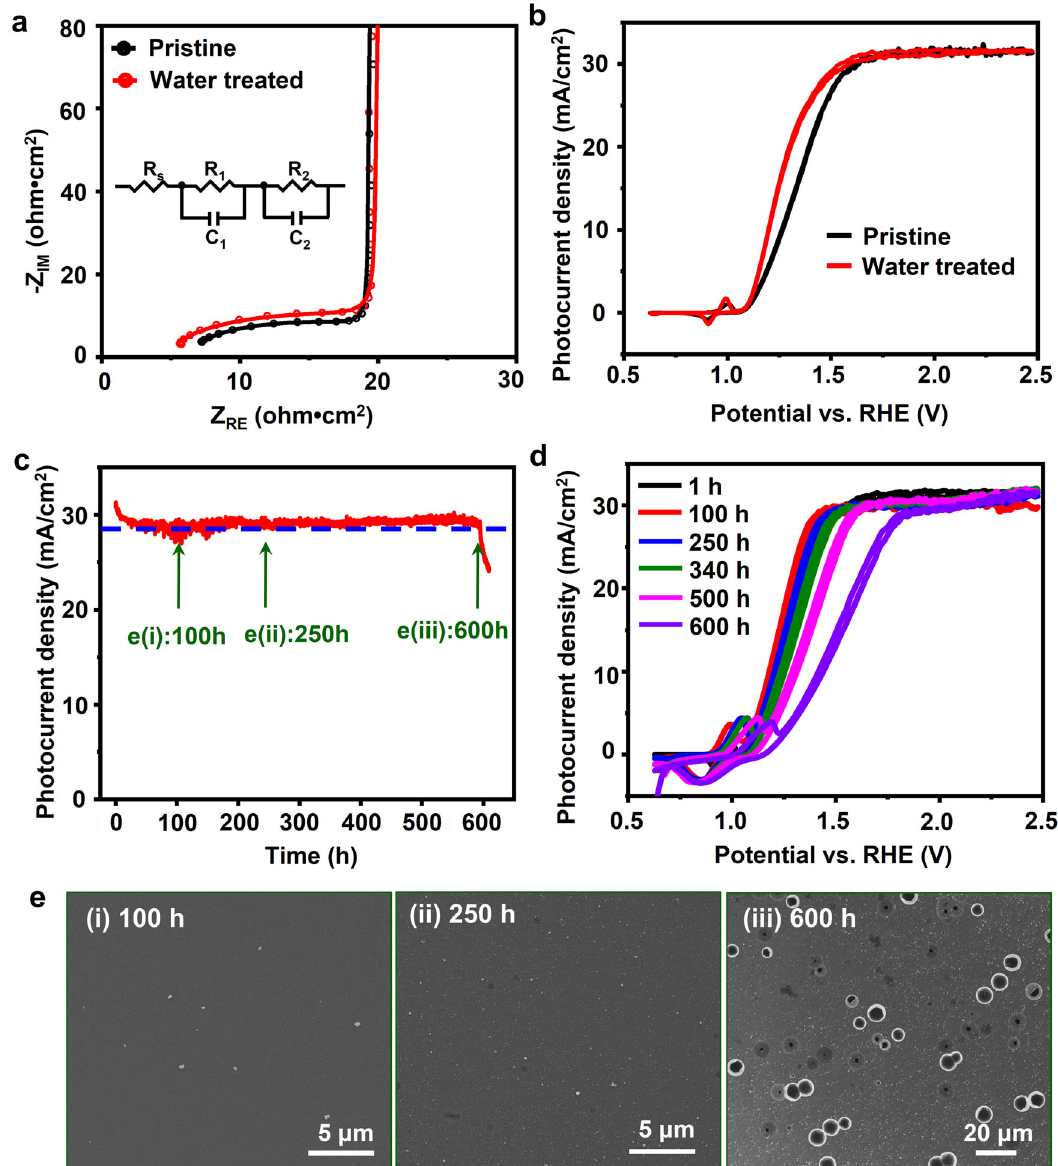
Fig. 5 | Lifetime evaluation of water-treated TiO 2 fi lm for Si photoanodes pro- 1sunilluminationatanexternalbiasof1.8Vvs.RHE.Thebluelinemarks90%ofthe tection. a EIS measurement of photoanodes protected by pristine and water- original J ph value. d J ph - V curves of Si/TiO 2 /Ni photoanode (with water treatment) obtainedataseriesoftimepointsfromthechronoamperometrytest. e SEMimages treated TiO 2 fi lms under 1 sun illumination. Inset is the equivalent circuit for curve V curves of Si/TiO fi tting. b J of the photoelectrode surfaces collected at 100h (i), 250h (ii), and 600h (iii) ph - 2 /Ni photoanodes protected by pristine (black) and water-treated(red)amorphousTiO 2 fi lms. c ChronoamperometryoftheSi/TiO 2 /Ni during the chronoamperometry test, revealing the very slow surface electrode (with water treatment) measured in 1.0M KOH aqueous solution under